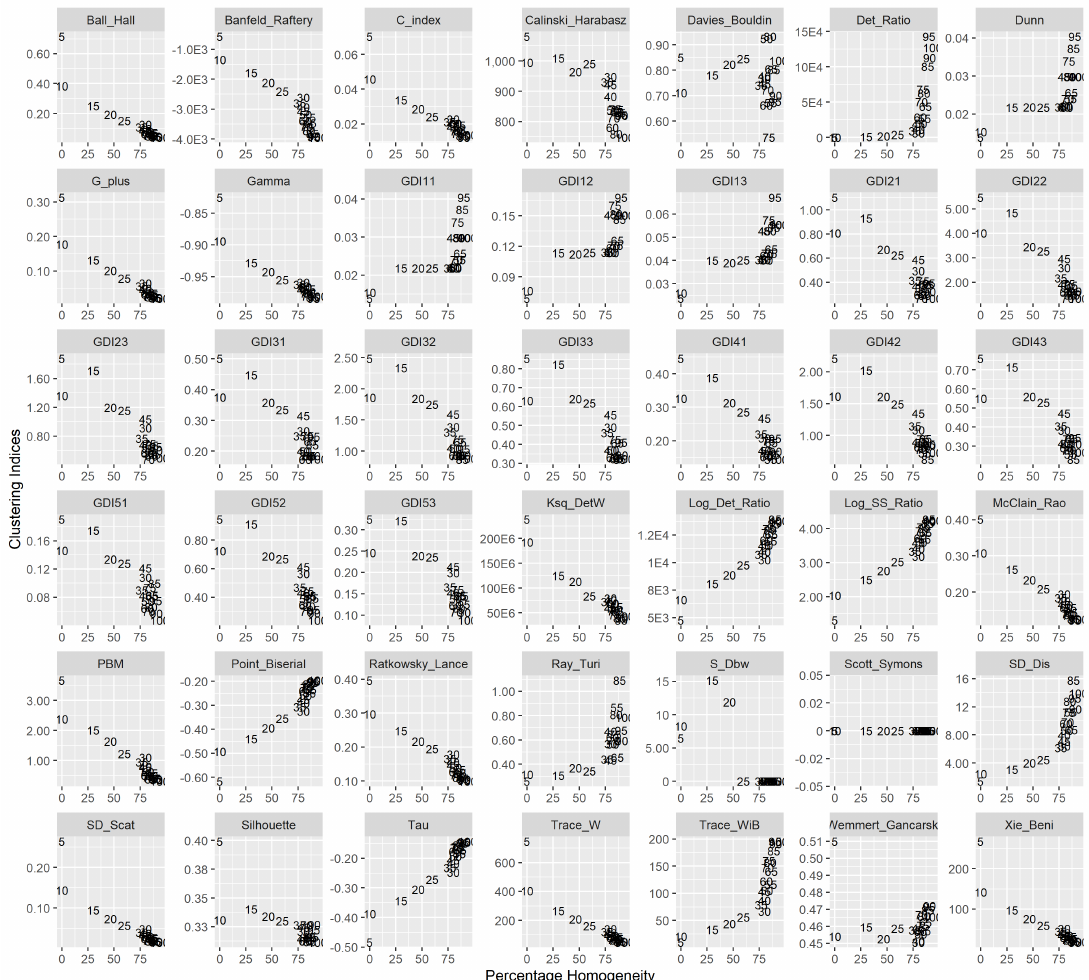
Figure 8. Performance of cluster validity indices in Prairie region—Autumn Season. The numbers indicate the percentage homogeneity for the number of clusters in the x-axis and CVI value on the y-axis. The scientific notation ‘E’ used in labels of y-axis represent ‘10 to the power of’. Table 1. Number of clusters and their corresponding percentage homogeneity values for the selected CVI for each season in Prairie region.